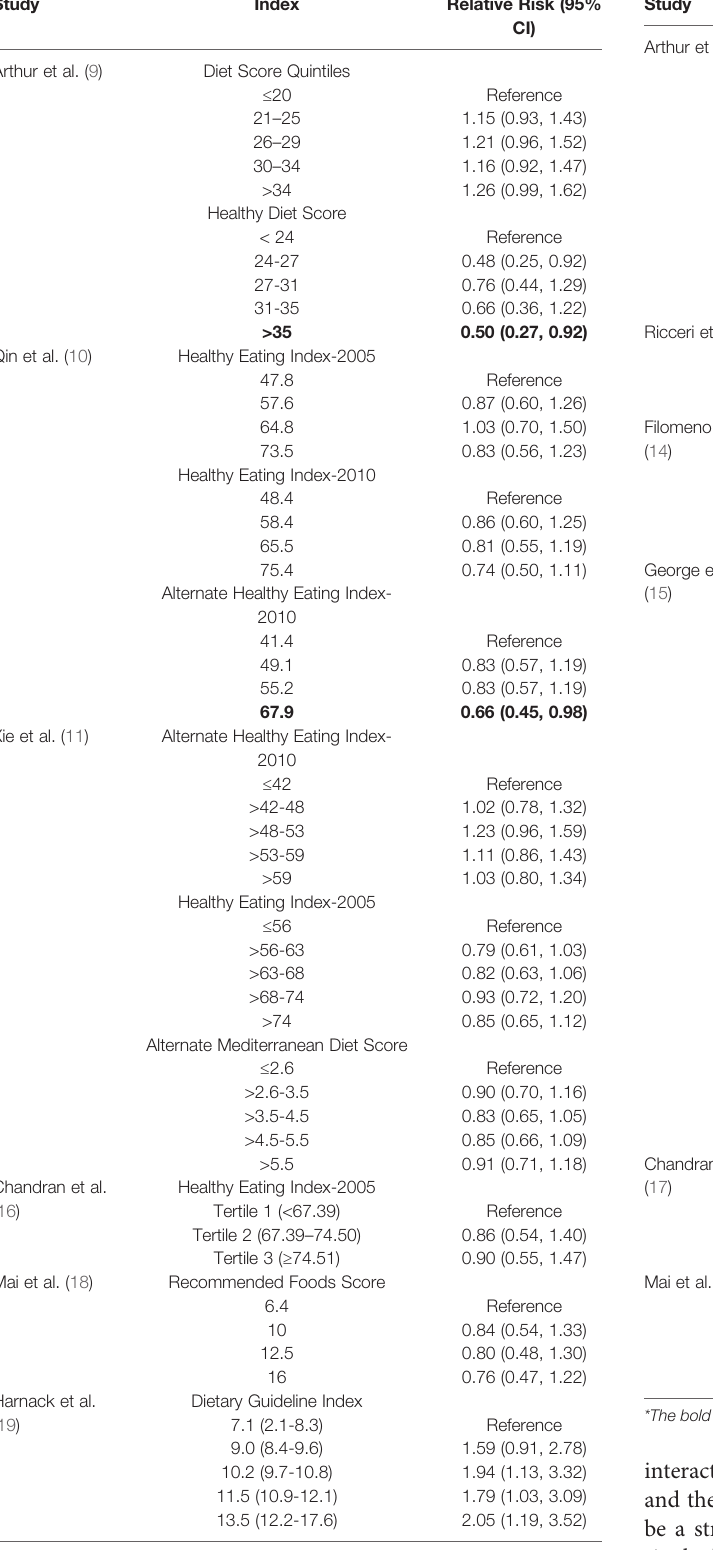
single dietary components (14).